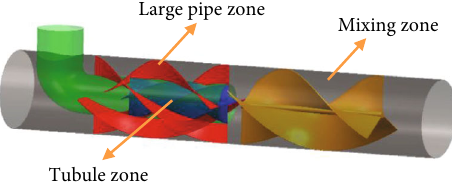
Figure 2: Naming of mixing unit